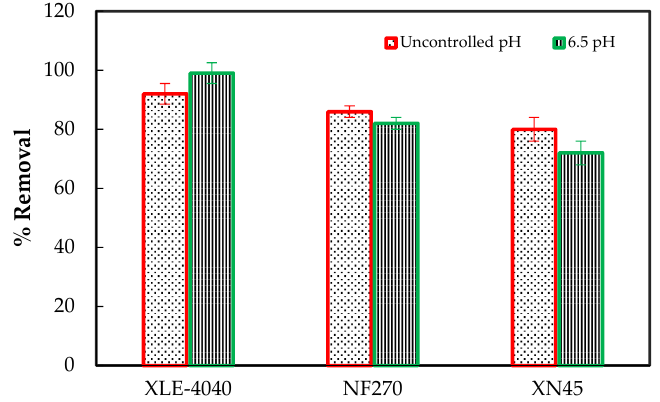
Figure 3. The measured effluents of the UF, NF, and RO membrane treatment at uncontrolled and controlled 6.5 pH pilot plant condition of chemical oxygen demand (COD) removal.